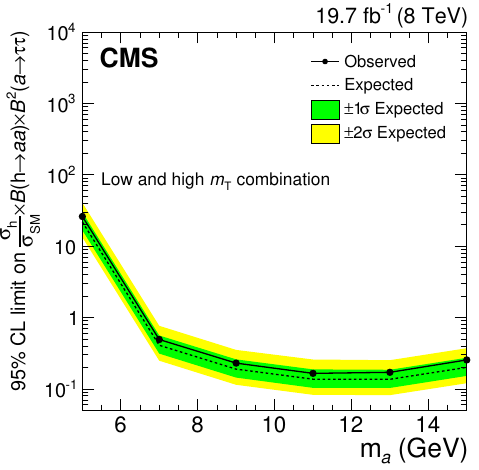
Figure 4 . Observed 95% CL limits on the branching fraction B (h ! aa) B 2 (a ! (cid:28) + (cid:28) (cid:0) ) assum- ing SM h production rates, compared to expected limits for pseudoscalar mass points between 5 and 15